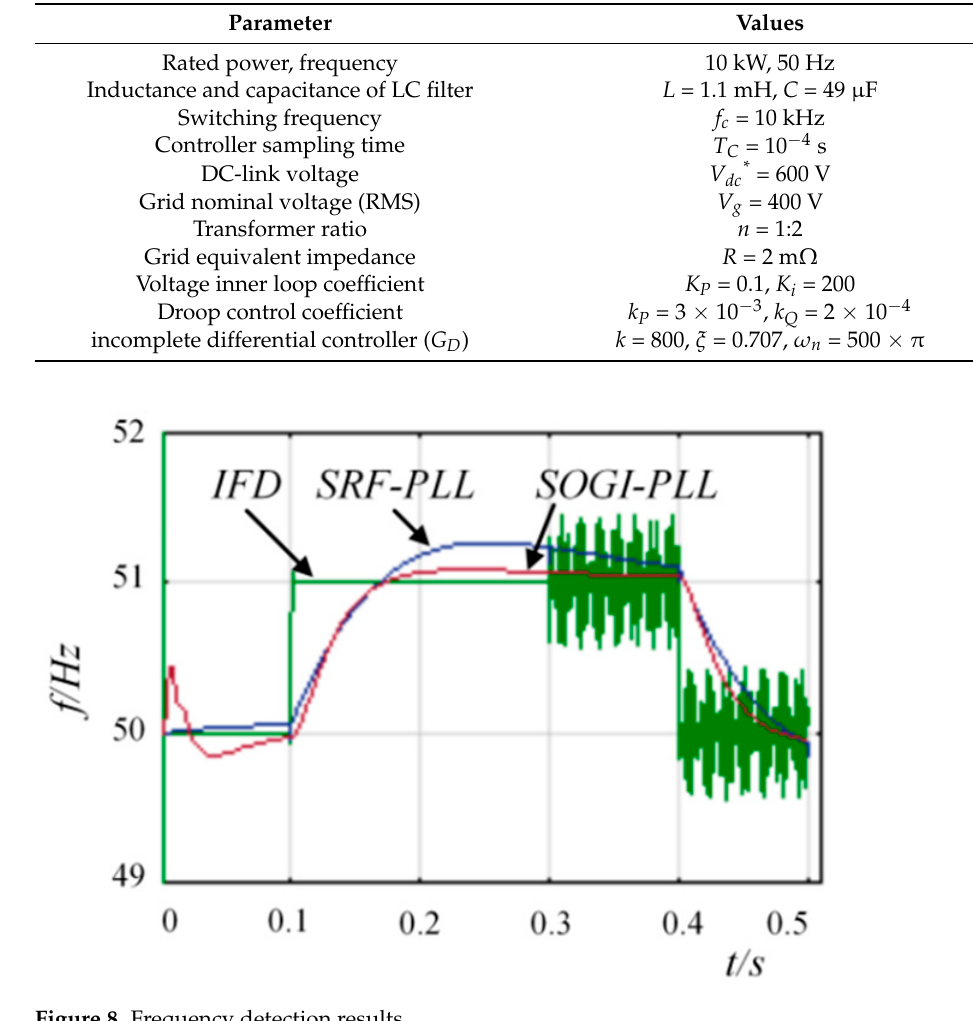
Figure 8. Frequency detection results.